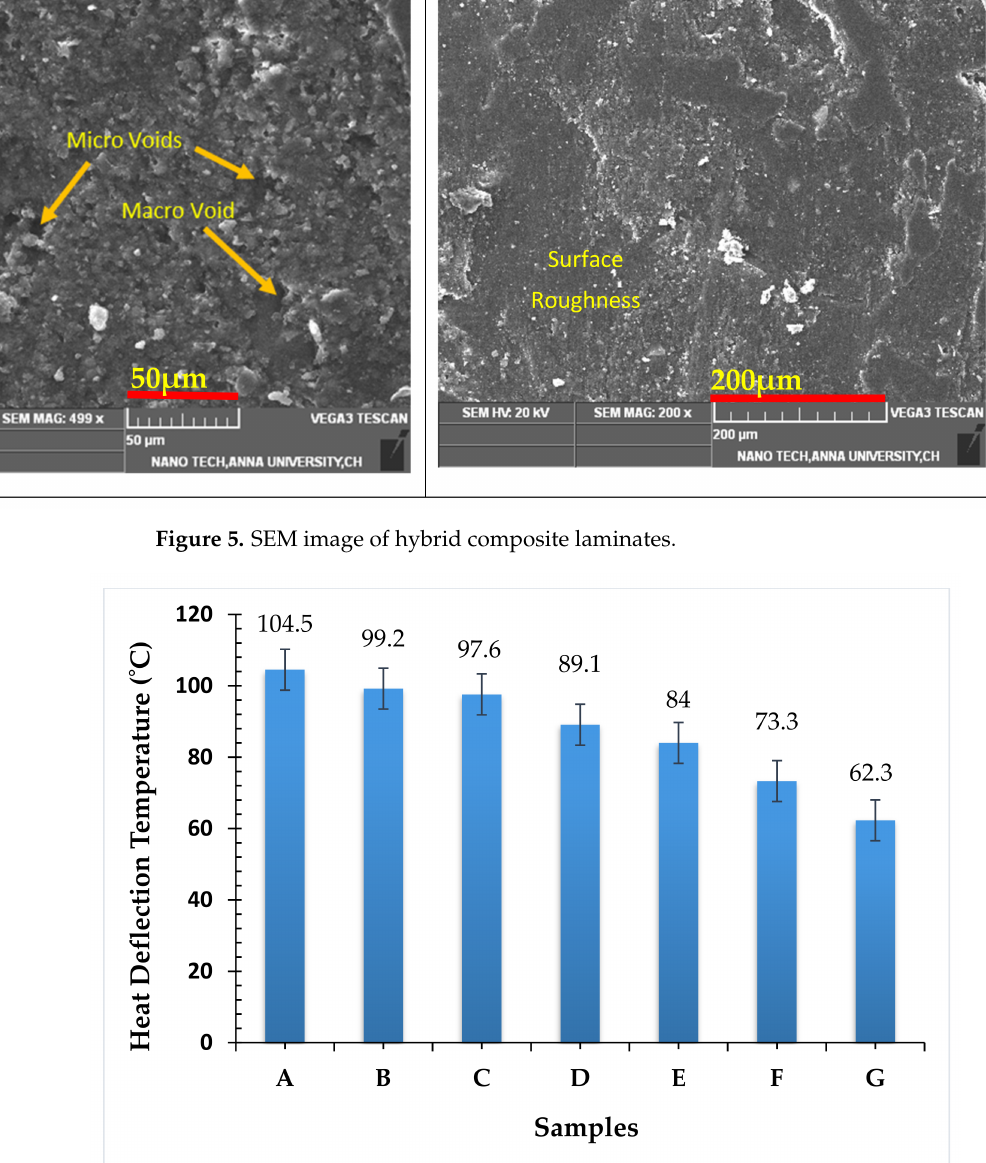
Figure 6. Heat deflection temperature of hybrid epoxy